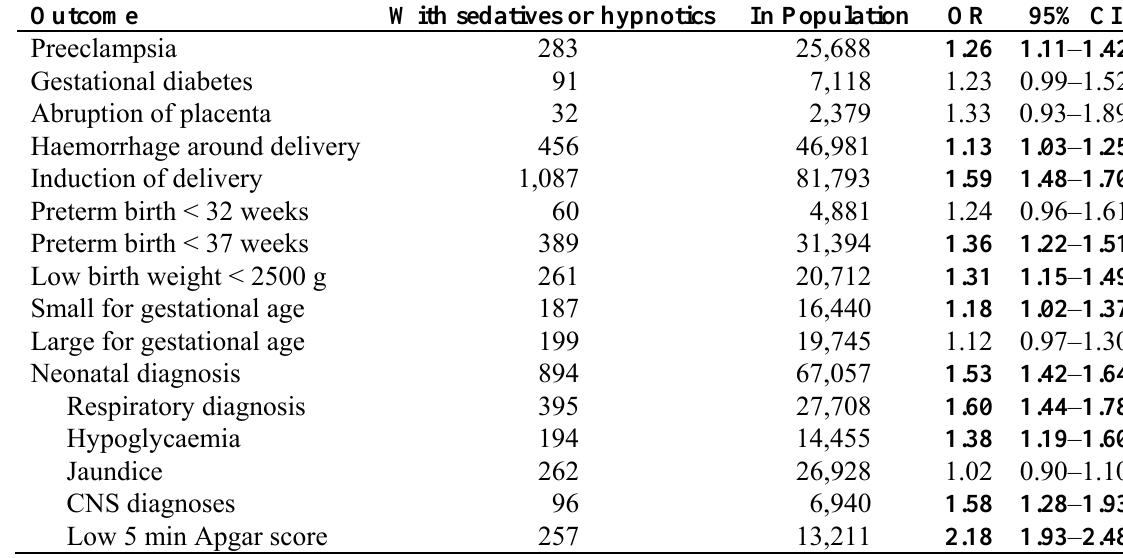
Table 26. Outcomes after maternal use of sedatives or hypnotics during the 2nd or 3rd trimester. Bold text marks statistical